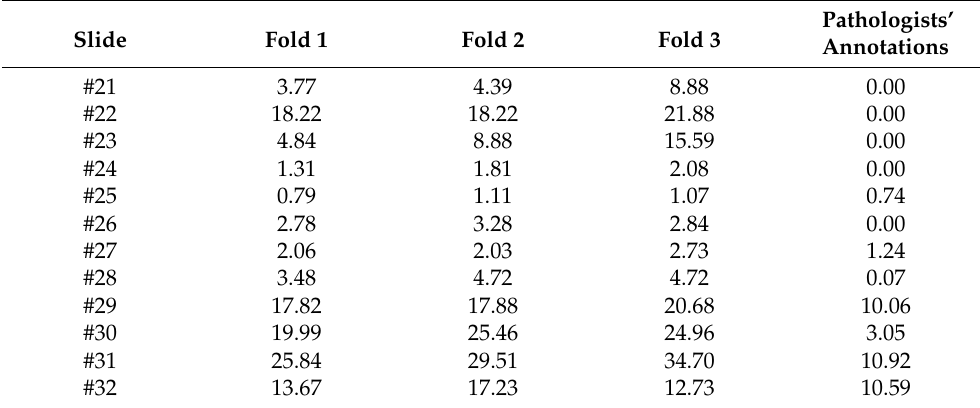
Table 5. Predicted % of necrosis that the algorithm detected in each slide after training and the % of necrosis annotated by the pathologists.